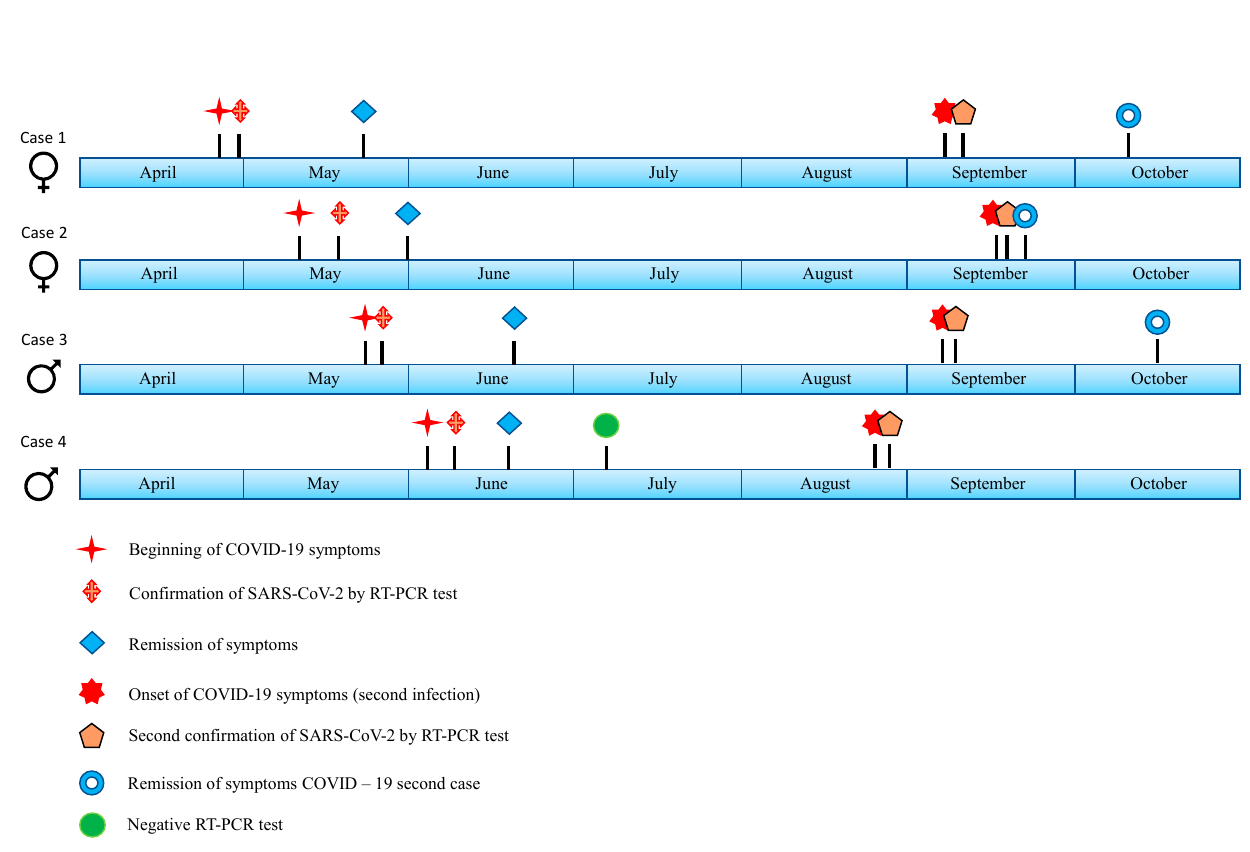
Figure 1. Timeline showing the most important clinical reinfection events in healthcare workers.